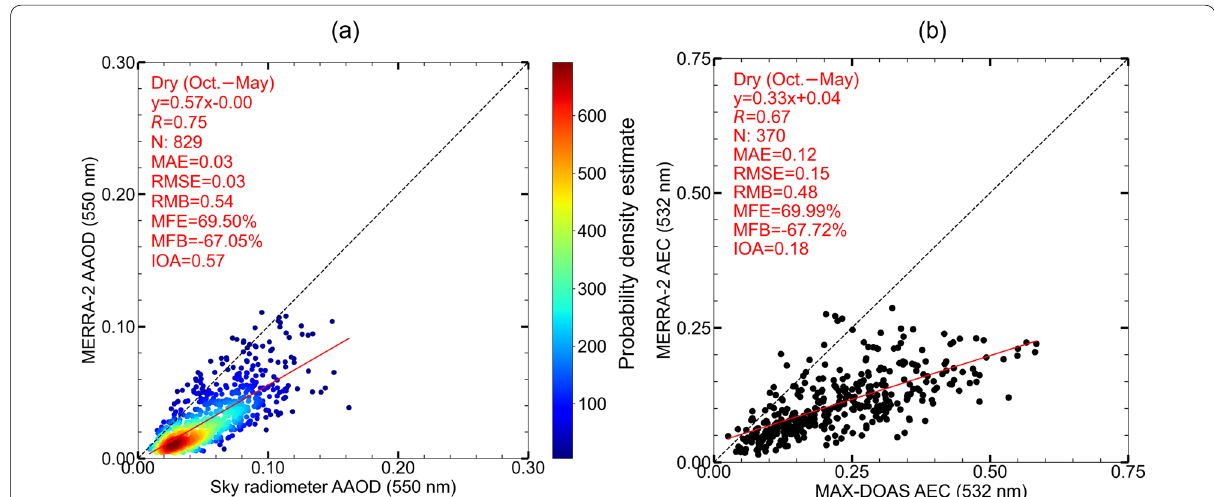
Fig. 3 Scatter density and scatter plots of hourly observations (x-axis) and MERRA-2 (y-axis) in the dry season from 2014 to 2019 at the Phimai SKYNET site. a Hourly absorption AOD (AAOD) (550 nm) and b aerosol extinction coefficient (AEC) (532 nm) at 0–1 km. Red line: regression line; black dashed line: 1:1 ratio. The color bar indicates the probability density derived from the kernel density